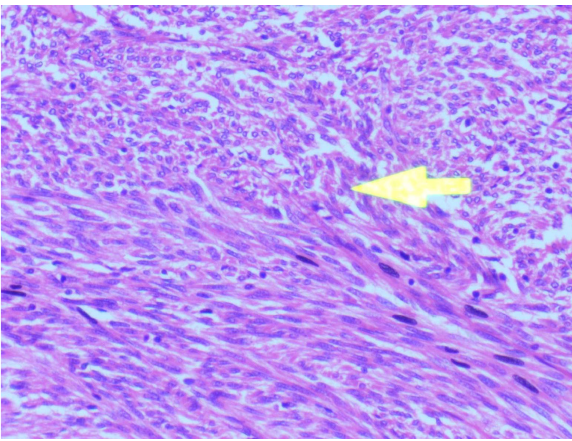
Figure 3: Spindle cells showing interlacing pattern. The indi- vidual cells have abundant cytoplasm and elongated nuclei with coarse chromatin.